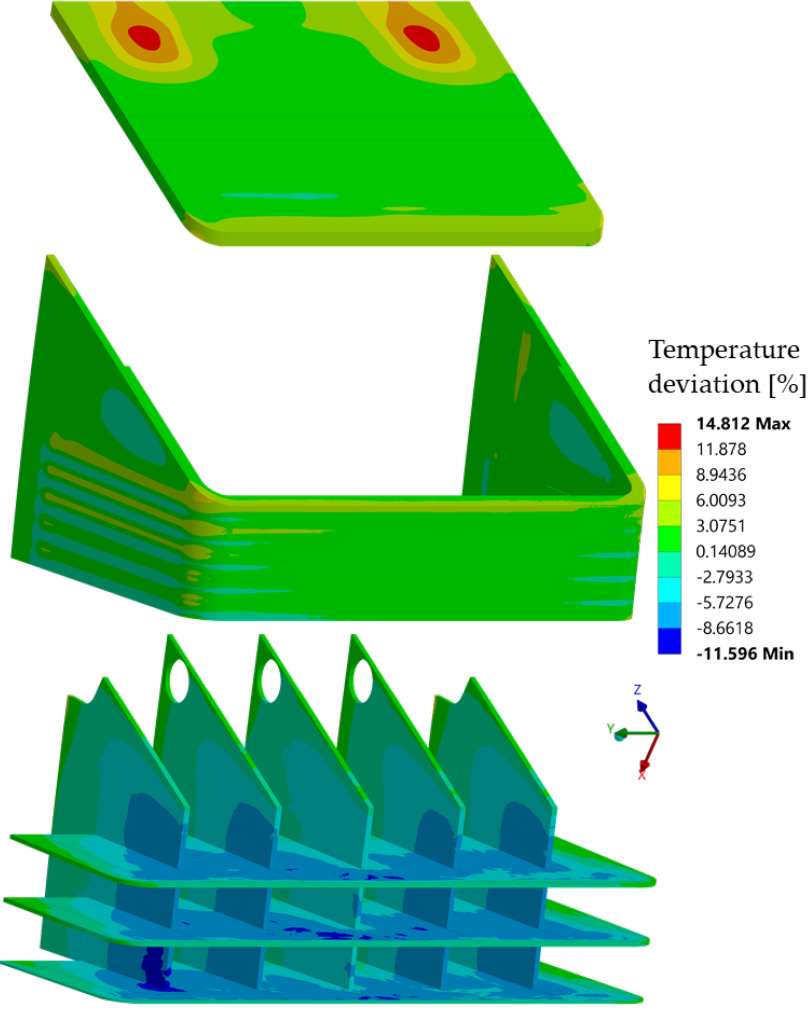
Figure 18. 3D contour map of the percentage temperature